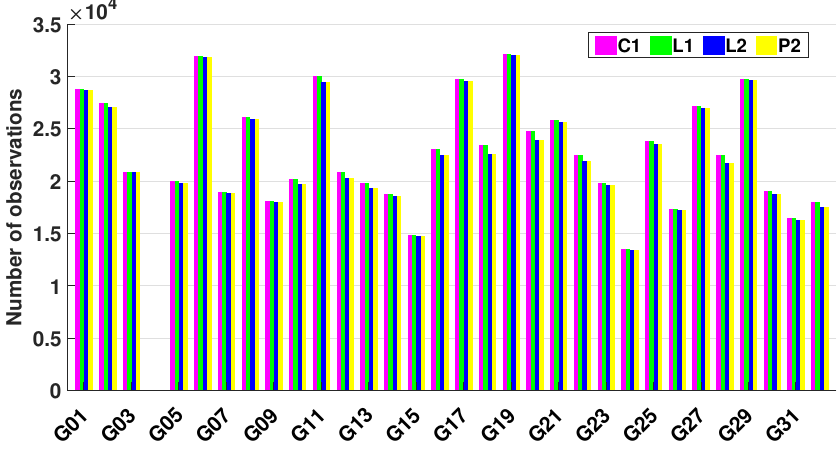
Figure 2. Observations collected by the TG02 onboard receiver for DOY 339, 2016. C/A (purple) and P2 (yellow) code measurements, as well as L1 (green) and L2 (blue) carrier phase observations. No data were collected for